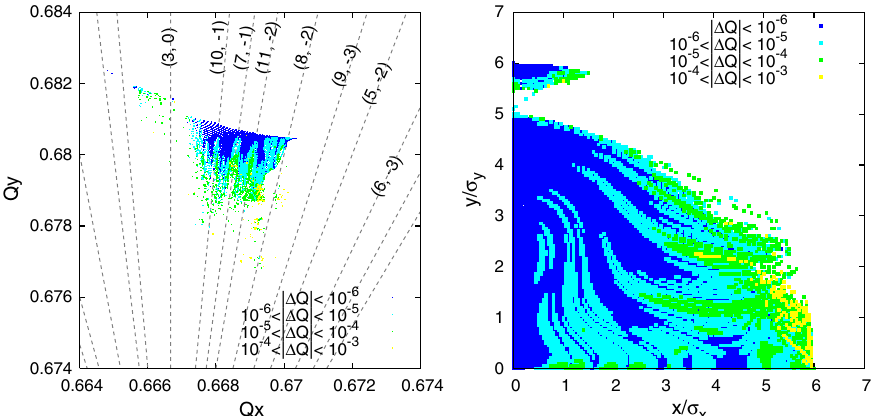
FIG. 6. Tune footprint (left) and tune diffusion map (right) of full head-on beam-beam compensation with the proton bunch intensity 2 : 5 (cid:2) 10 11 . The fractional zero-amplitude tunes are (0.67, 0.68). Particle loss is observed in 2048